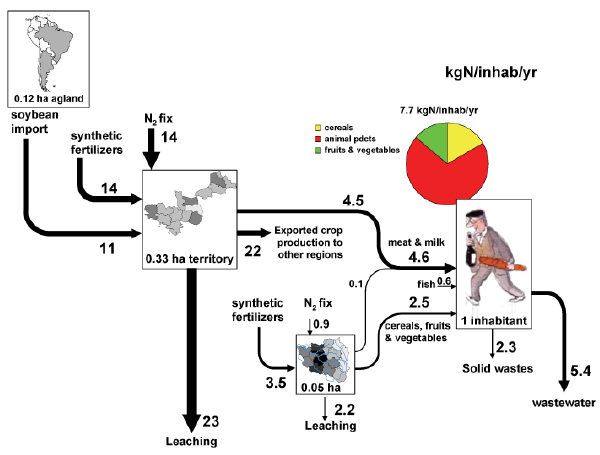
Fig. 1. Schematic representation of the nitrogen imprint of the food supply of one Paris inhabitant. Nitrogen fluxes involved are ex- pressed in kgNinhab − 1 yr − 1 . The figures are derived from the de- scription established in Billen et al.